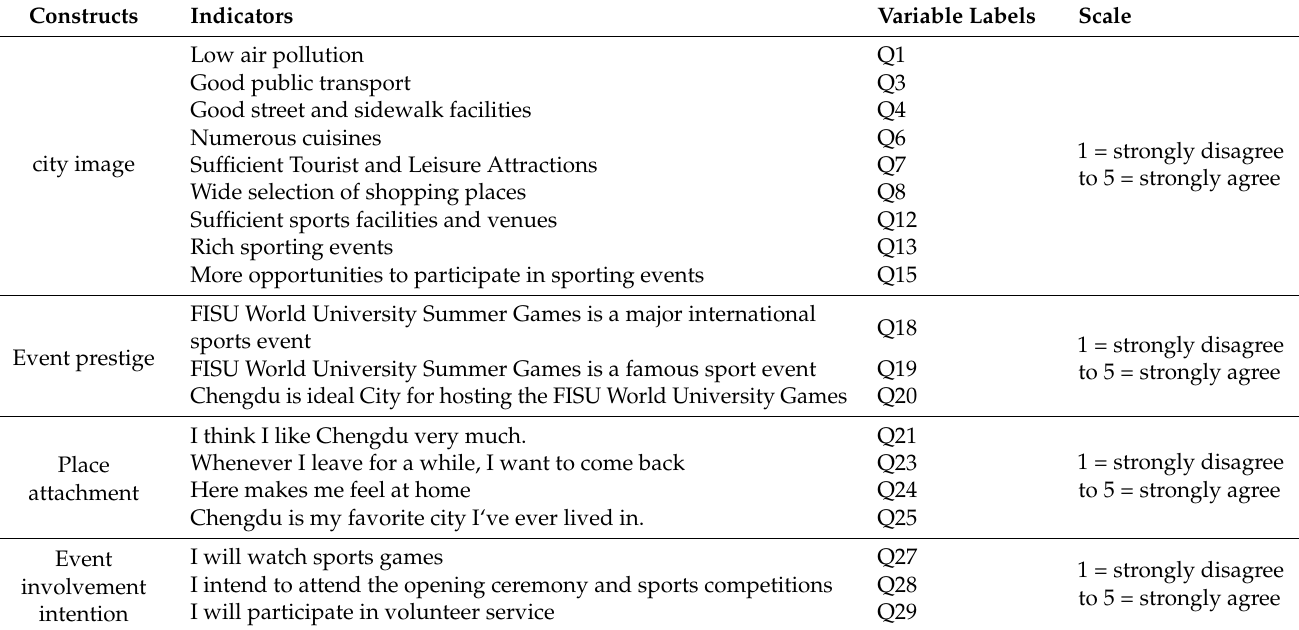
Table A1. Summary of items selected for each of the study’s